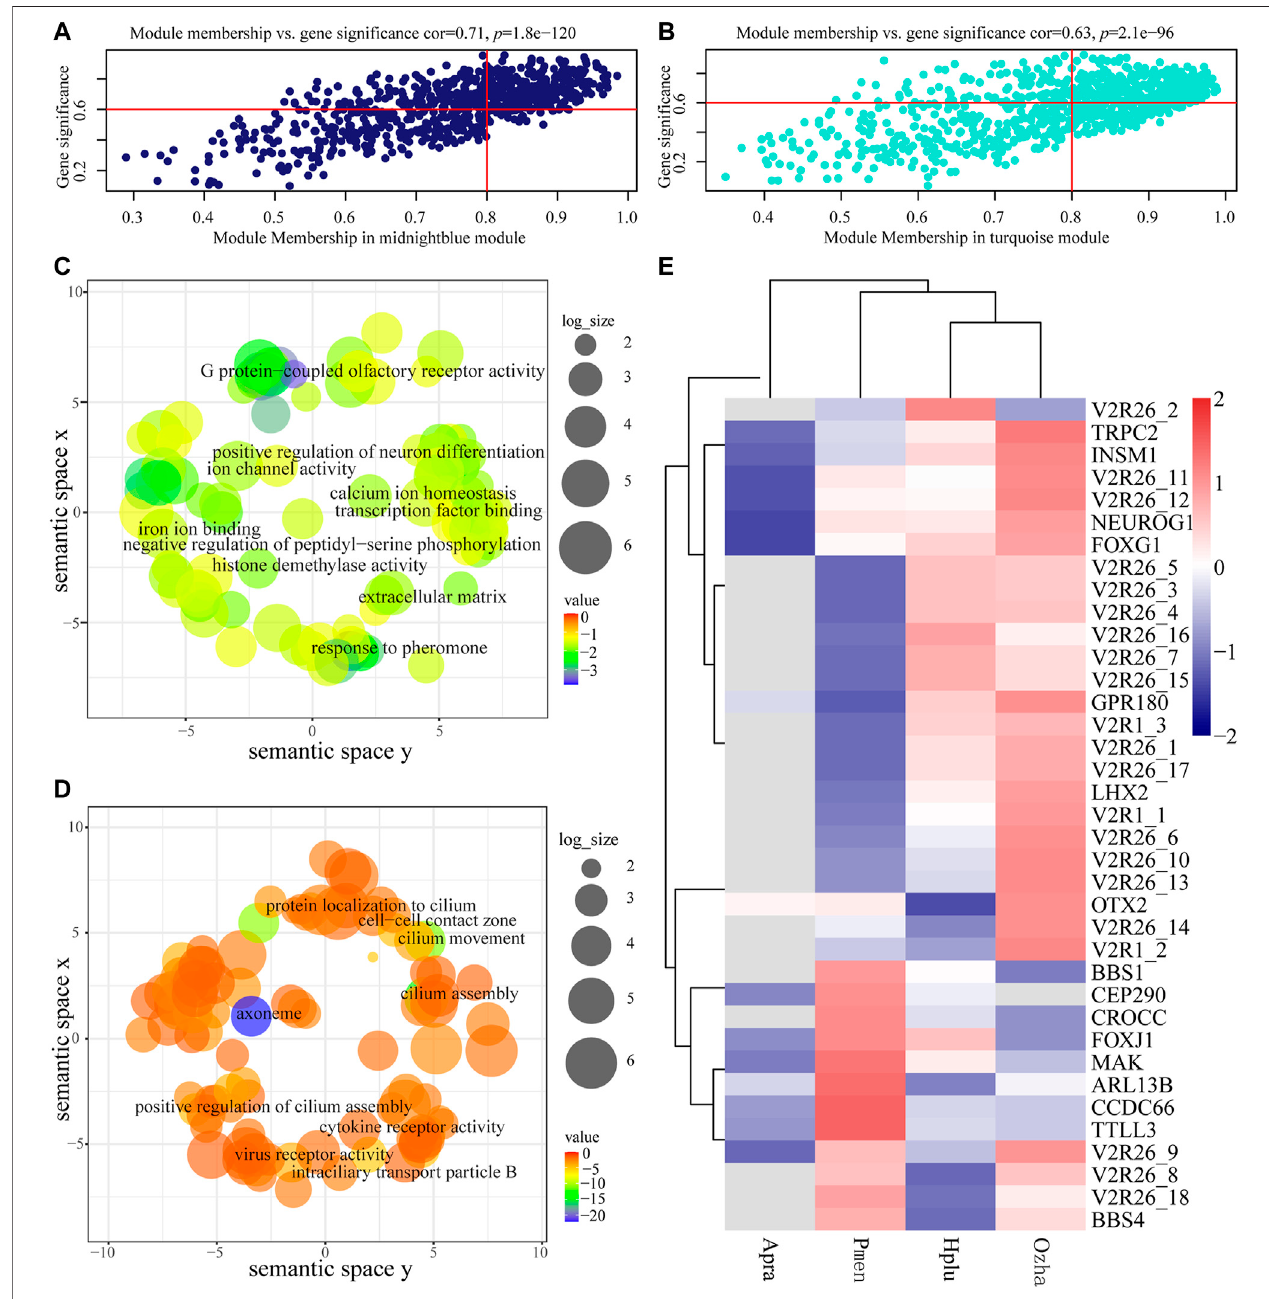
FIGURE6| Analysisoftheaquatic AOS(midnight-blue) module andthenon-aquaticAOS(turquoise)module. (A) Scatterplotsofgenesigni fi cance (GS)forhabitat traits versus module membership (MM) in the aquatic AOS module. (B) Scatterplots of gene signi fi cance (GS) for habitat traits versus module membership (MM) in the non-aquatic AOS module. (C) GO enrichment analysis of genes in the aquatic AOS module was visualized using REVIGO. (D) GO enrichment analysis of genes in the non-aquatic AOS module was visualized using REVIGO. (E) The expression of olfactory-related genes in the two modules.